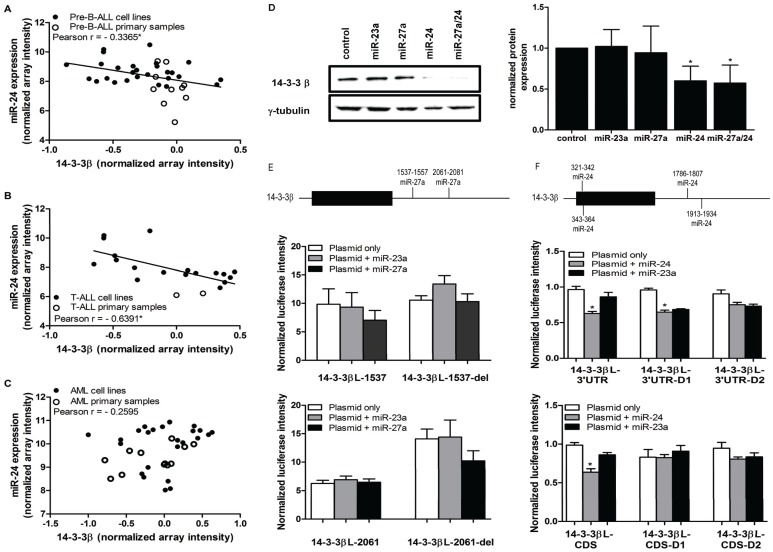
MiR-24, but not miR-27a regulates 14-3-3β via sites in the 3′UTR and CDS.(A)–(C) Expression of mature miR-24 and 14-3-3β mRNA were measured via microarray. Correlation plots of 14-3-3β and miR-24 expression in (A) pre-B-ALL (n = 37), (B) T-ALL (n = 20), and (C) AML (n = 36) cell lines and primary samples are shown. Significant inverse correlation was determined via Pearson r (r<−0.03, p<0.05*). (D) The effect of miR-23a cluster members on endogenous 14-3-3β protein expression was measured via Western blot. The left panel is a representative blot from one experiment, and the right panel is a graph of normalized protein expression from 4 independent experiments (±SEM), determined by densitometry analysis (p<0.05*). (E) A schematic showing predicted miR-27a binding sites in the 3′UTR of 14-3-3β (top). HEK293T cells were co-transfected with 14-3-3βL-1537 or 14-3-3βL-1537-del (middle panel), and 14-3-3βL-2061 or 14-3-3βL-2061-del (bottom panel) (500 ng, white bars) alone and with 25 nM of miR-23a (grey bars) or miR-27a (black bars). Normalized mean Luc expression (±SEM, n≥3) is represented on the graph. (F) A schematic shows predicted miR-24 binding sites in the CDS and 3′UTR of 14-3-3β (top). HEK293T cells were co-transfected with 14-3-3βL-3′UTR (or deletion mutants 1 and 2; middle panel) or 14-3-3βL-CDS (or deletion mutants 1 and 2; bottom panel), (500 ng, white bars) alone and with 25 nM of miR-24 (grey bars) or miR-23a (black bars). Normalized mean Luc expression (±SEM, n≥3) is represented.